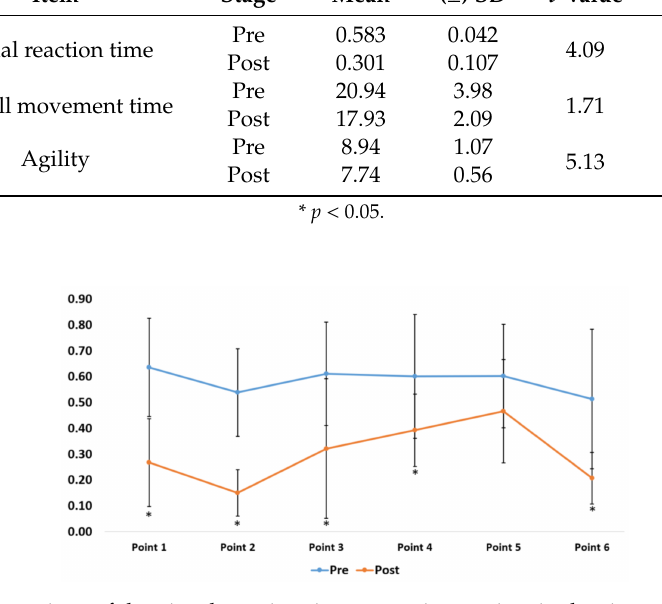
Figure 7. A comparison of the visual reaction times at various points in the six-point footwork